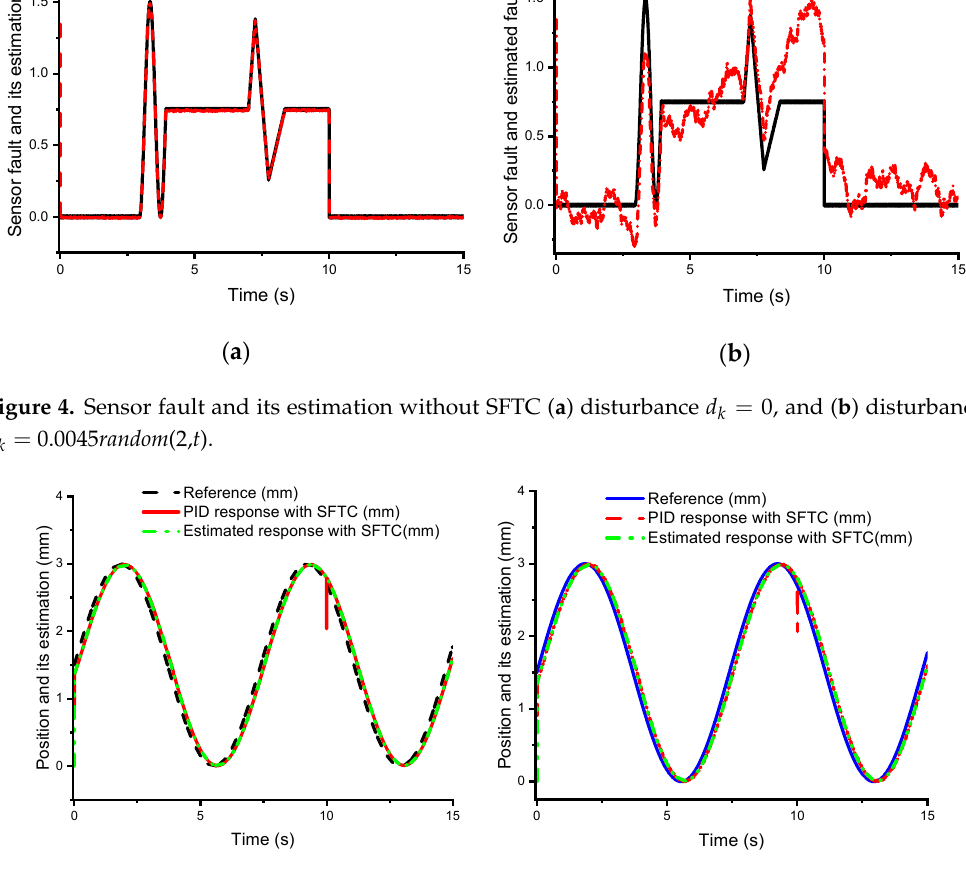
d = , and ( b ) disturbance k